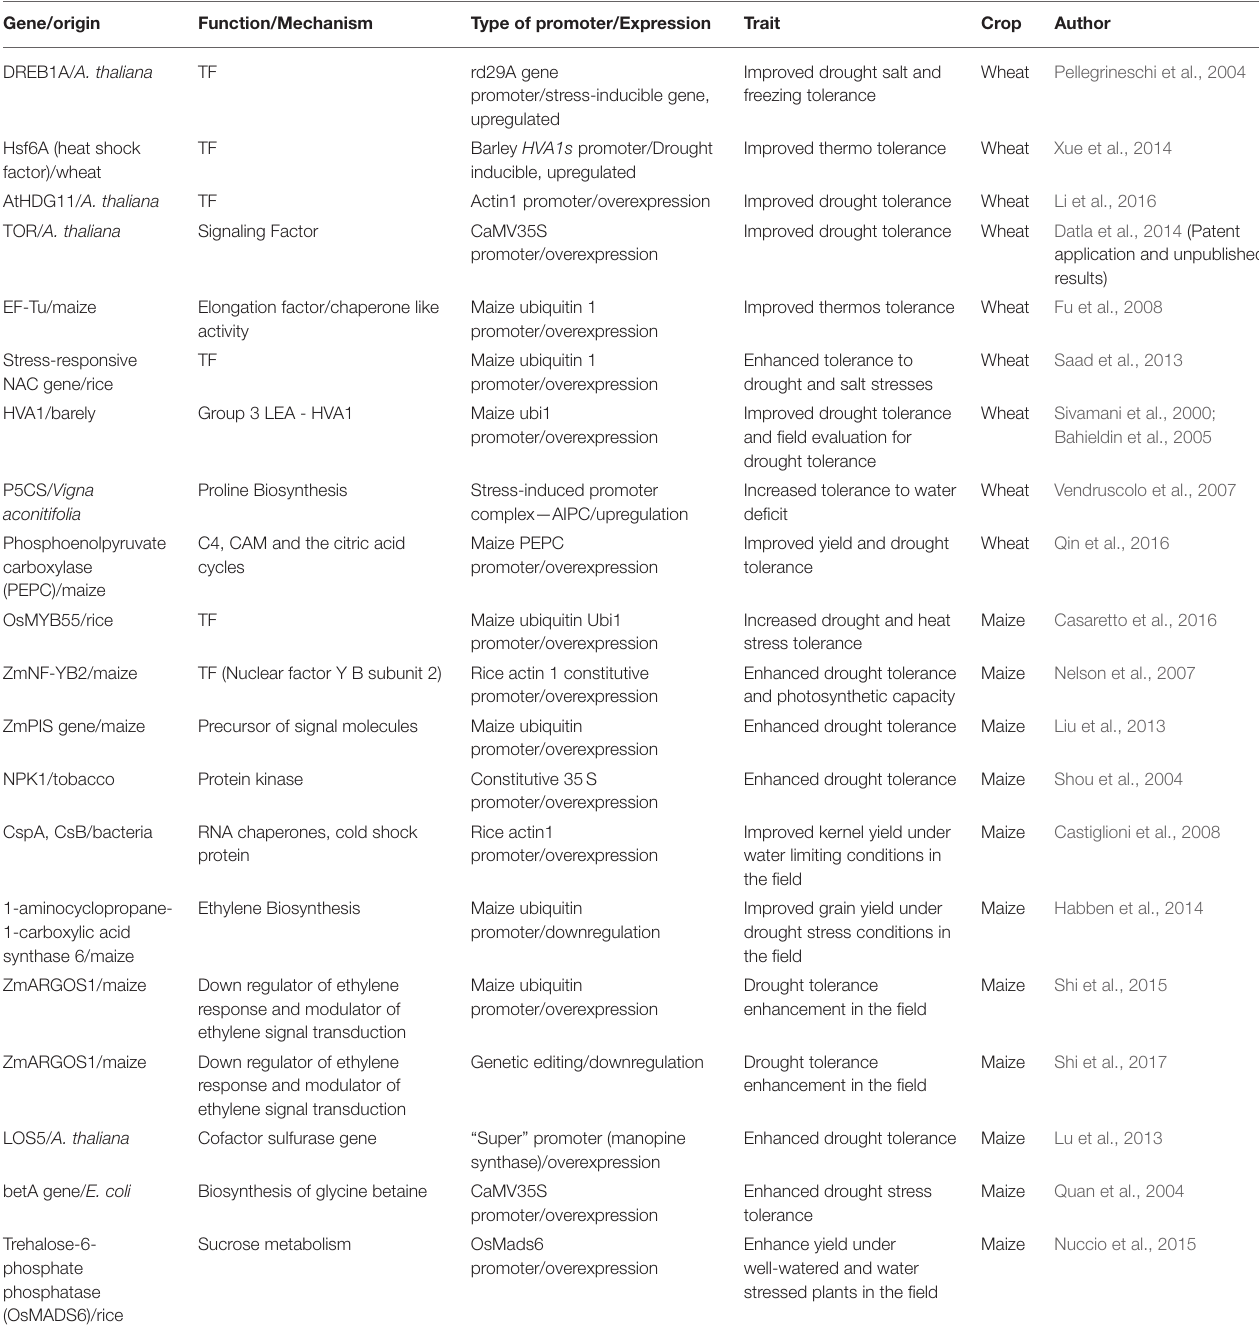
TABLE 1 | Summary of genes that were shown to have a role in heat and drought tolerance in wheat and